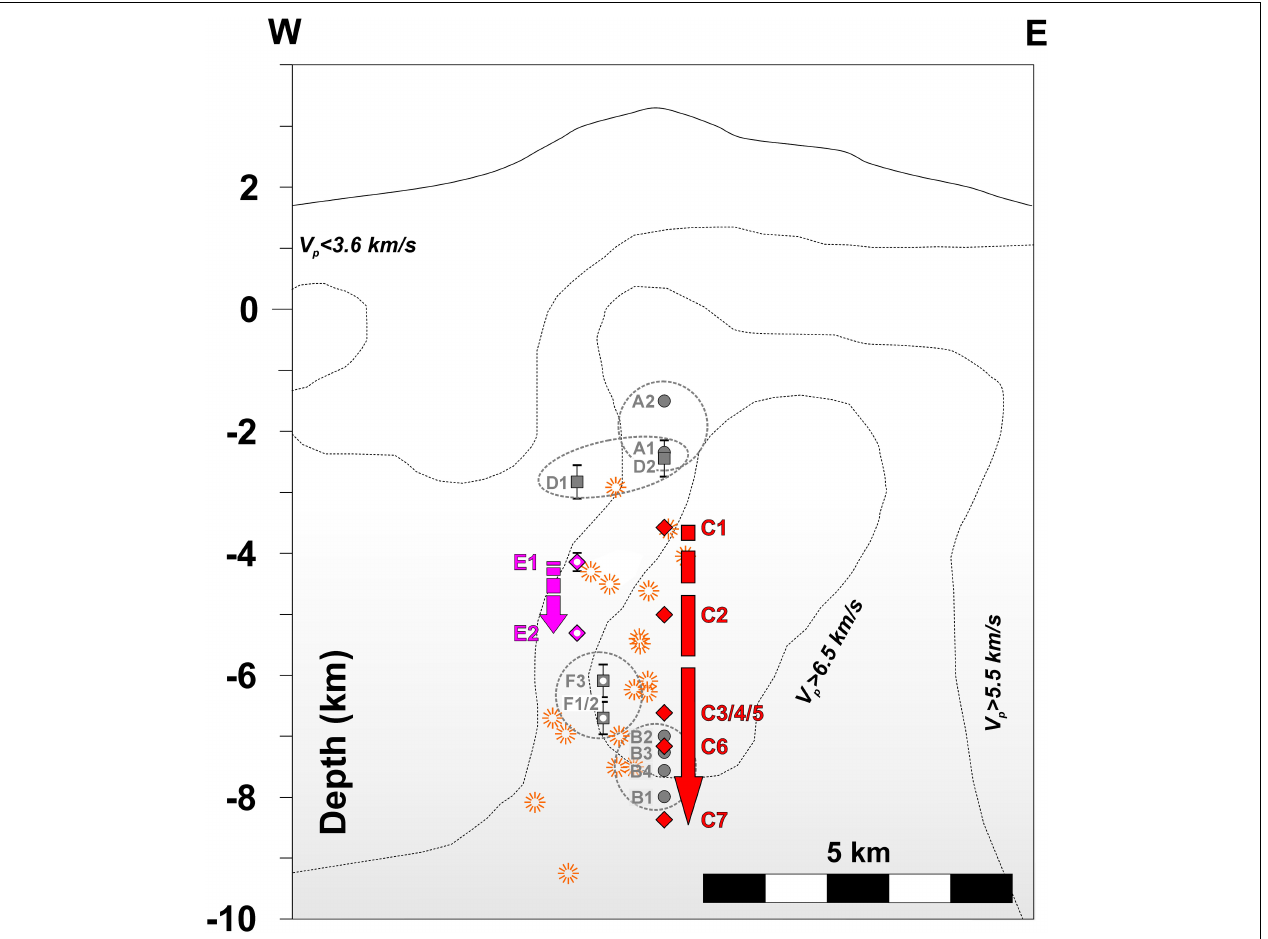
FIGURE 6 | W-E section of Mt. Etna showing the position of the recharging sources inferred by both previous studies (see Table 4 ), indicated by asterisks, and this investigation specified by numbered capital letters (see Table 3 ). The C (1993–2001) and E (2009–2010) recharging phases preceding high explosive eruptive periods show a clear lowering of the source depth over time. The error bars, reported in Table 3 , are visible for the cases in which the associated error exceeds the dimension of the asterisk symbols representing the position of the inflation